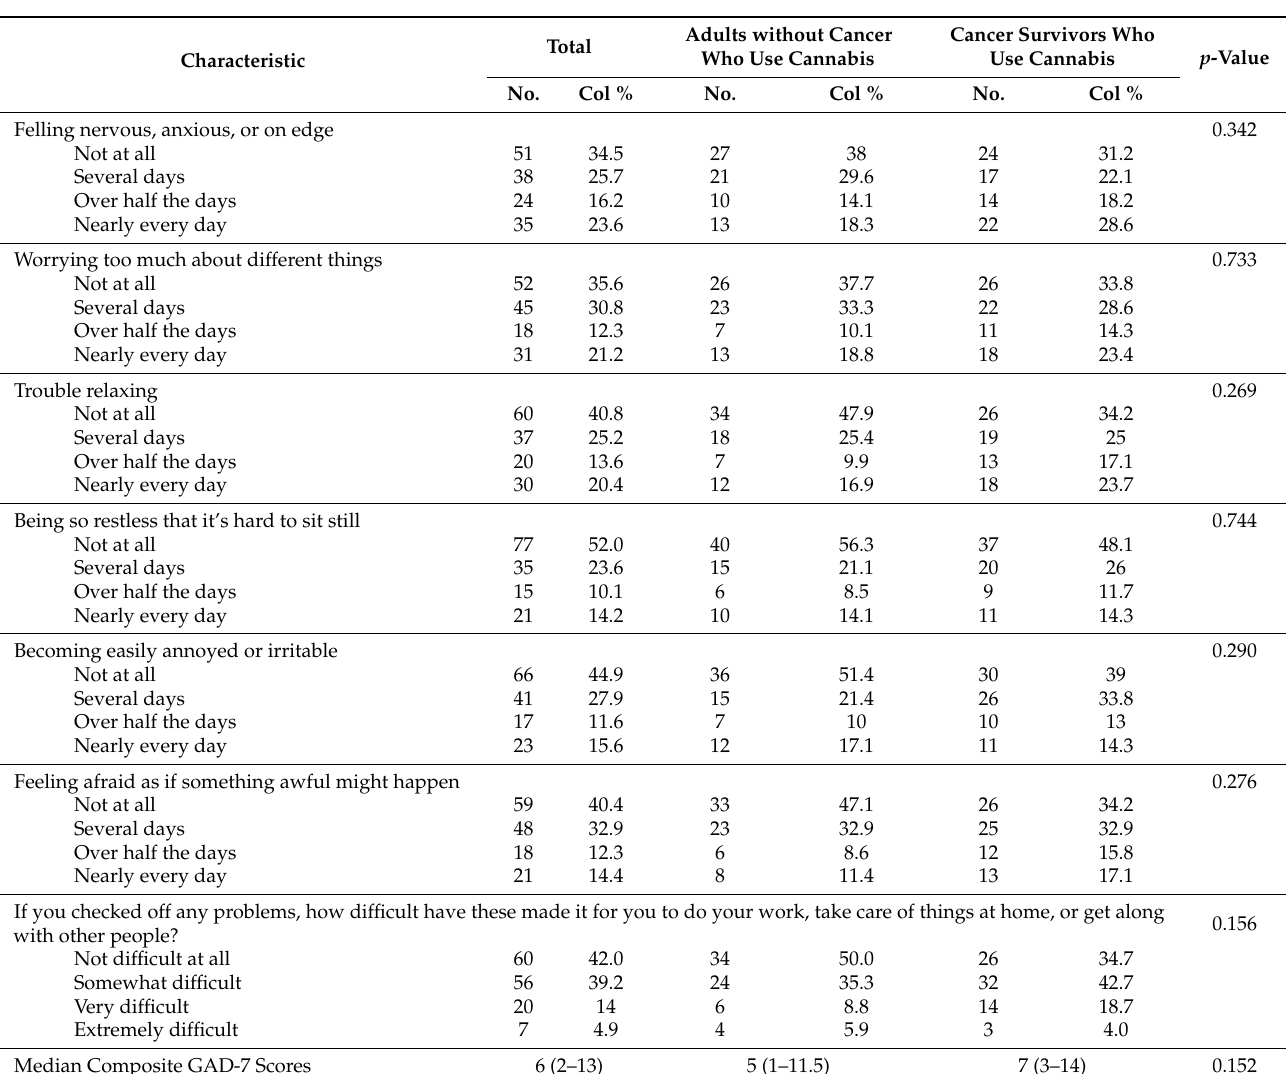
Table 2. ComponentsoftheGAD-7questionnaireamongcancersurvivorsandadultswithoutcancer( n =